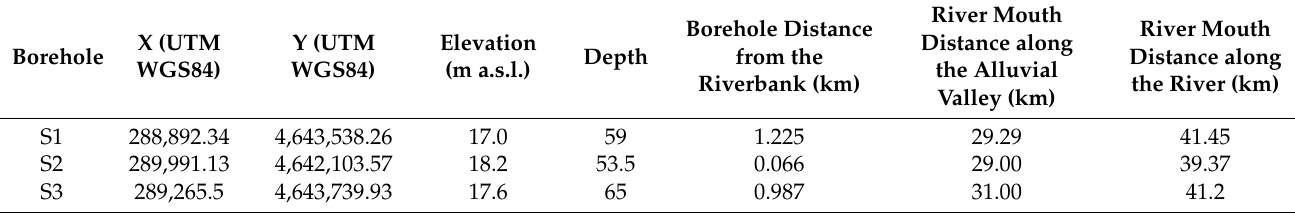
Table 2. Coordinates (UTM WGS84, 33N), elevation, and depth of drilled boreholes. The distance between the wells and the riverbank was calculated orthogonally to the axis of the river. The distance between the well and the mouth of the river, along both the median of the alluvial valley and the river channel, was also